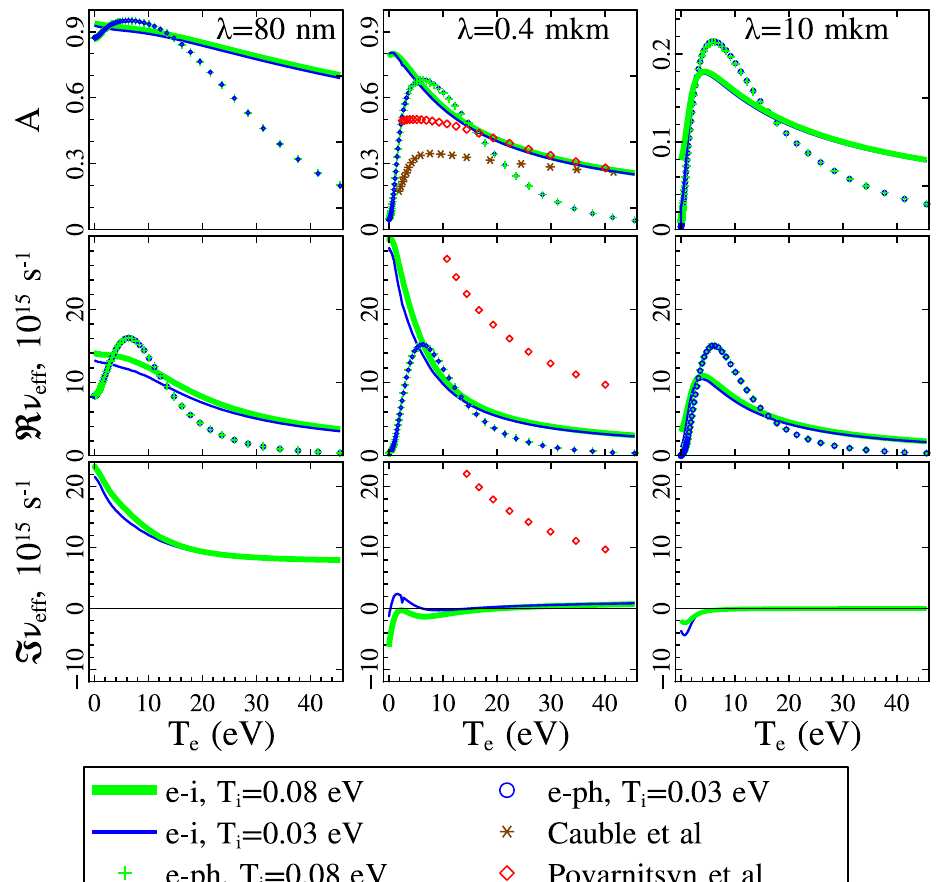
Figure 1. Absorption coefficient (first row) as well as real (second row) and imaginary (third row) parts of the complex collision frequency of electrons (46), as a function of the electron temperature T e , for a solid-density aluminum plasma ( (cid:36) = 2.71 g/cm 3 ) and laser radiation of different wavelengths λ (left column: 80 nm; center: 0.4 µ m; right: 10 µ m). Curves are shown for different ion temperatures (see legend), calculated for the case of an ordered lattice by Models (46), (51), and (52) (with an account of electron–phonon interactions and Umklapp processes, labeled by “e-ph”), as well as for the case of a disordered lattice (electron–ion and electron–electron interactions, labeled by “e-i”). Curves with the markers “*” and “ (cid:5) ” are according to the models cited in the text (see legend).